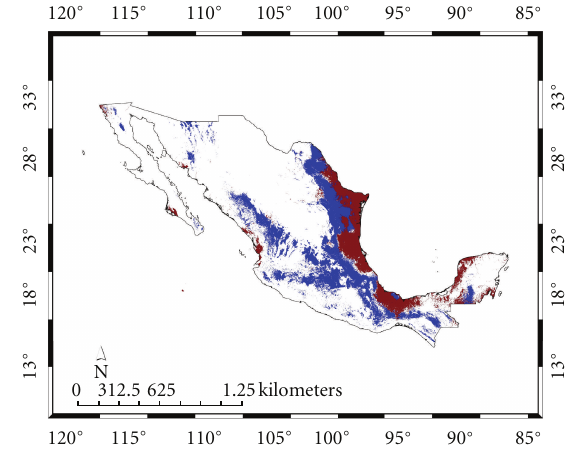
Figure 3: Complementarity of models for Amblyomma cajennense and the Ixodes